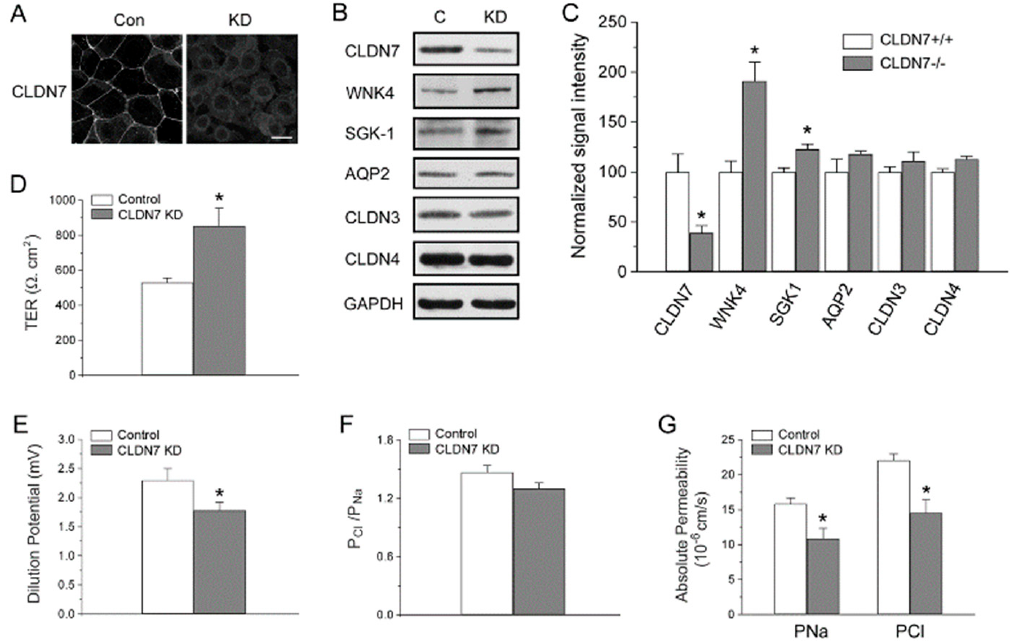
Figure5. KnockdownofCLDN7inCLDN7 +/+ CDcellsdecreasedparacellularCl − andNa + permeability. ( A ) CLDN7 +/+ CD cells were transfected with either control (Con) or CLDN7 shRNA (KD) vector. The indirect immunofluorecent method shows the reduced immunostaining signal of CLDN7 in KD cells compared to that of control cells. ( B ) The control and knockdown (KD) cell lysates were subject to western blot analysis. Membranes were probed against CLDN7, WNK4, SGK-1, AQP2, CLDN3, and CLDN4. GAPDH was used as a loading control. ( C ) Densitometry analysis of protein expression levels shown on ( B ). Each band intensity for CLDN7 +/+ CD cells was normalized and set as a reference. * p < 0.05. n = 3. ( D ) The control and KD CD cells were cultured in Transwell plates coated with collagen. TER was measured on monolayers cultured for 7 days. ( E ) The control and KD CD cells were grown on collagen-coated Snapwell filters for 7 days. The dilution potentials were measured as described in Figure 2B. ( F ) The ratio of the absolute permeability of Cl - to Na + (P Cl / P Na ) was calculated using the Goldman–Hodgkin–Katz equation. ( G ) The calculated absolute permeability for P Cl and P Na was significantly reduced in KD cells compared to that of control cells. * p < 0.05. n = 3. +/+ Transfection of CLDN7 back to the CLDN7 KD cells (KD + CLDN7) increased the